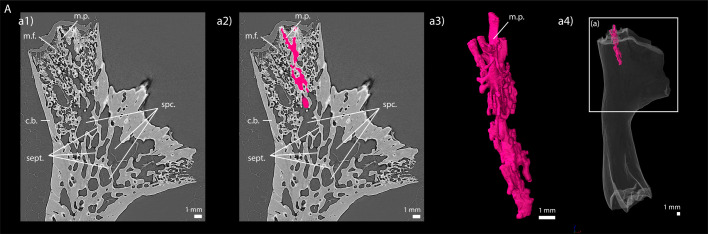
Longitudinal virtual sections and three-dimensional (3D) segmentation from PPC-SRµCT of marrow processes in the humeral proximal end of (A) Andrias sp.(MNHN-ZA-AC-2005–72, Museum national d’Histoire naturelle, Paris, France). (a1) Longitudinal virtual thin section (60 µm thick), (a2) marrow processes segmented, (a3) 3D model of the segmentation and (a4) location of a3 in the humerus. The humerus of Andrias has been imaged using the protocol published by Sanchez et al., 2014. Abbreviations: c.b., cortical bone; m.f., mineralisation front; m.p., marrow process; sept., septa; spc., spaces.